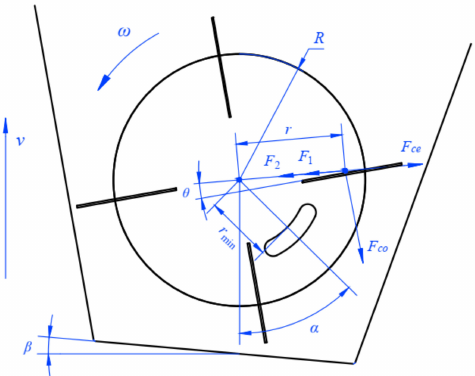
Figure 5. Analytical model of the mechanical state of fertilizer particles when on the centrifugal